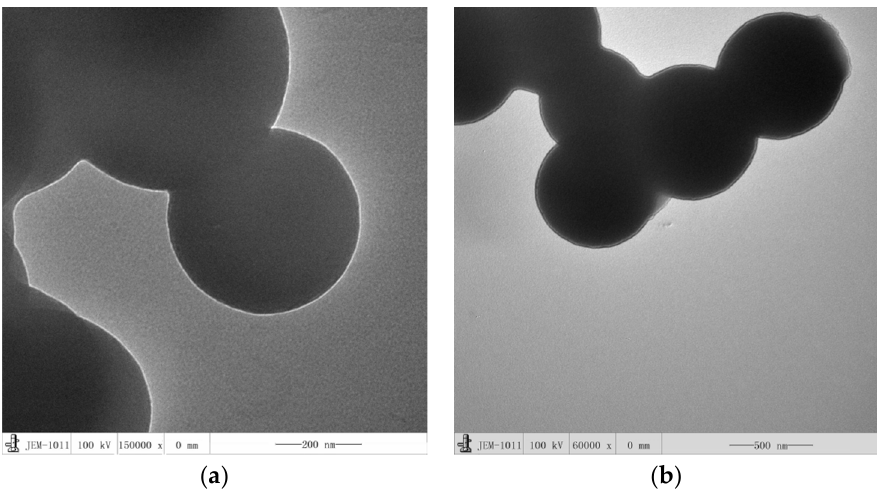
Figure 3. The transmission electron microscope (TEM) image of OCMSs ( a ) and FCMSs ( b ).